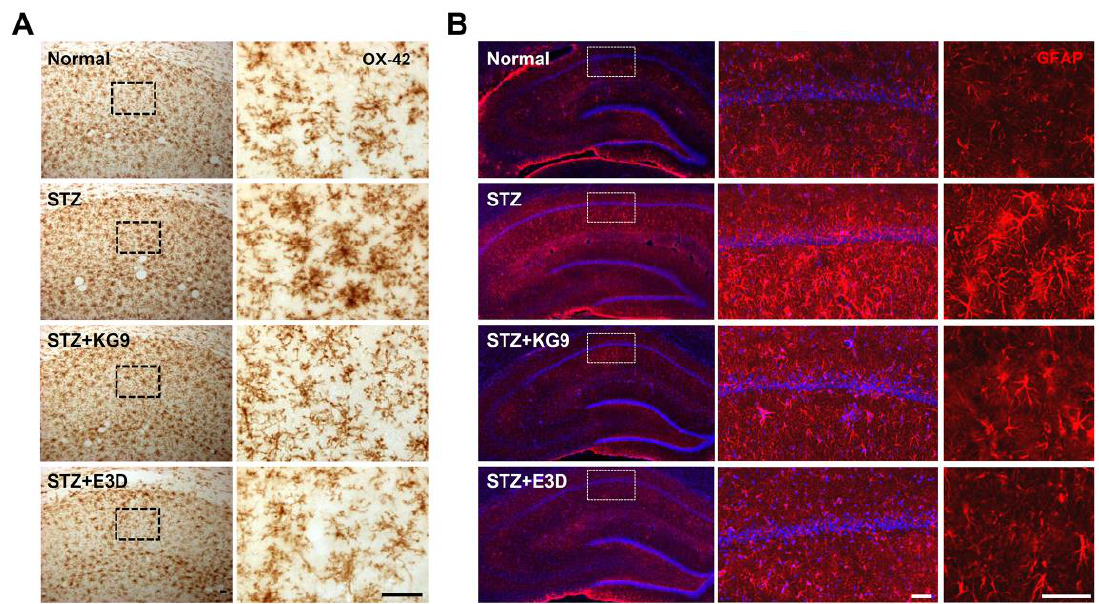
Figure 7. GS-KG9 and GS-E3D inhibit microglia and astrocyte activation in the hippocampus of STZ-induced diabetic rats. At 28 d after GS-KG9 and GS-E3D (300 mg / kg) treatment, brain tissue samples were prepared as described in the Materials and Methods section and we performed immunostaining with microglia marker (OX-42) and astrocyte marker (GFAP). Representative photographs of OX-42 ( A ) and GFAP ( B ) immunohistochemistry showing the hippocampal area. The right panels are higher magnification images of the box area in the left panels. Scale bars, 50 μm. 3.7. GS-KG9 and GS-E3D inhibit the expression of pro-inflammatory cytokines and mediators in STZ-